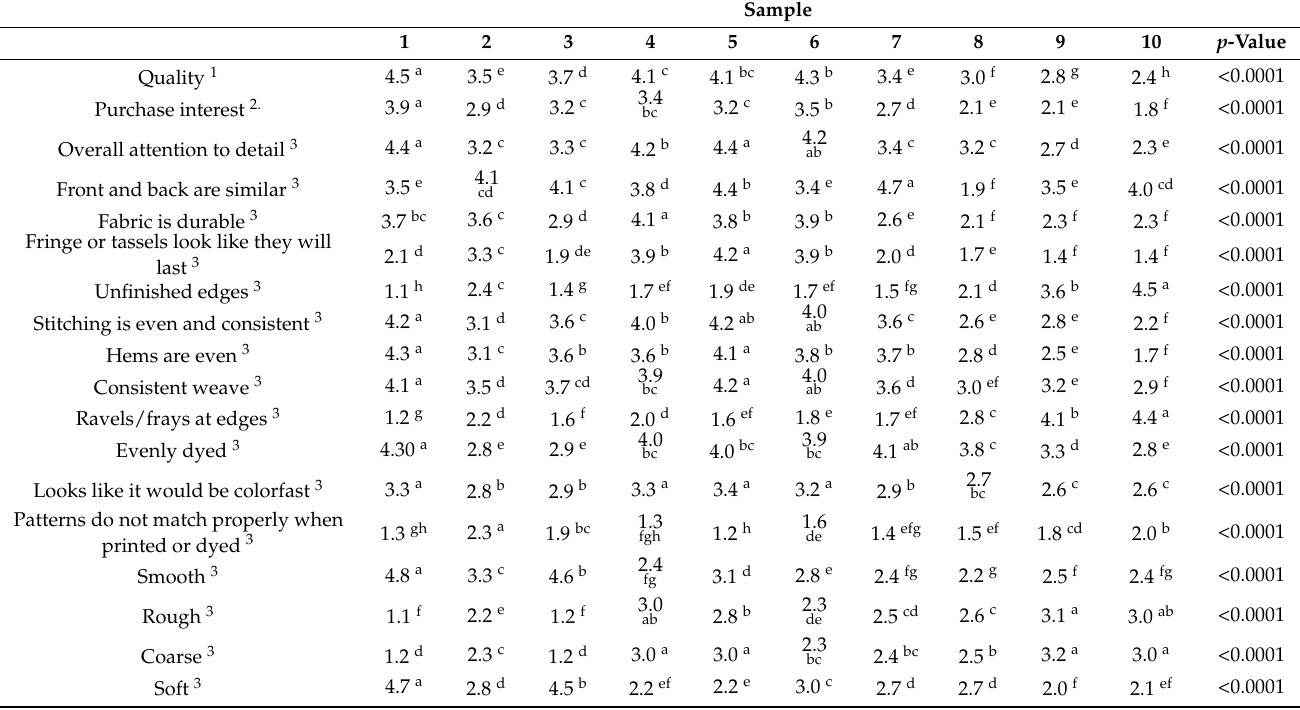
Table 6. LS means for consumers’ ratings for quality, purchase interest, and the 30 quality statements for textiles ( α =